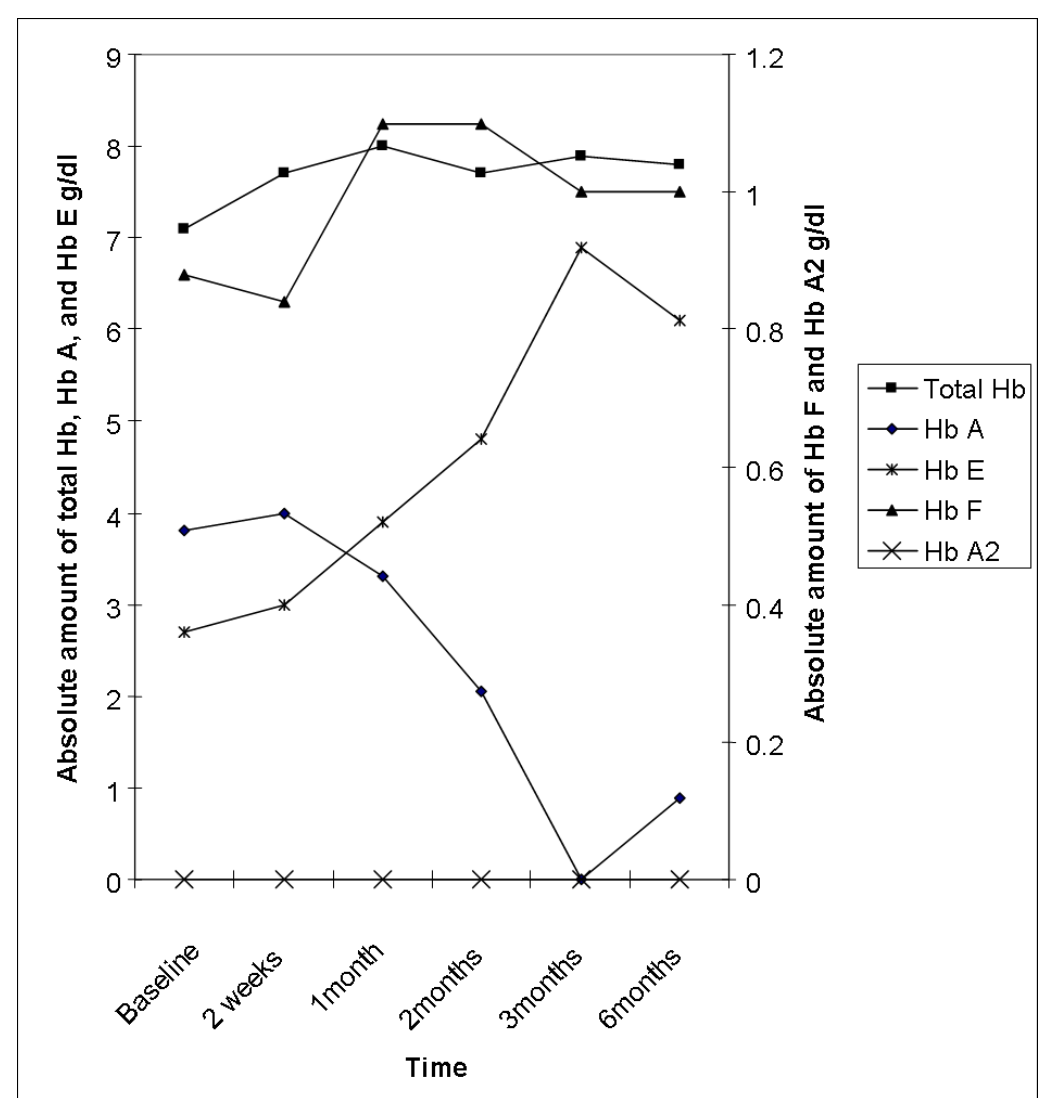
FIGURE 2. Hemoglobin type change at 2 weeks, 1, 2, 3, and 6 months postinfusion of RSC into a patient with beta-thalassemia/Hb E (intermedia) disease when compared to baseline. This patient became transfusion independent postinfusion of the